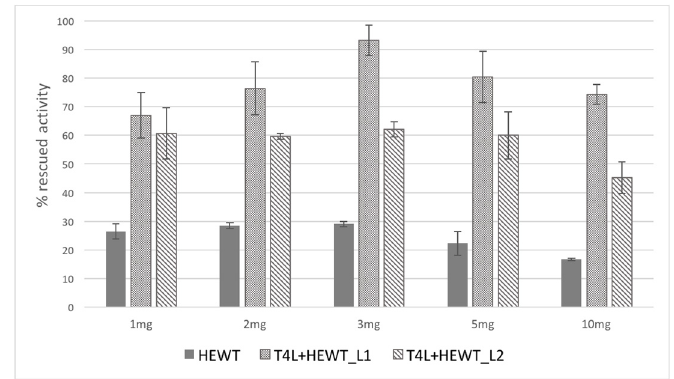
Figure 2. HEWT, T4L + HEWT_L1 and T4L + HEWT_L2 immobilisation (24 h, room temperature, in 50 mM phosphate buffer pH 8) at different enzyme loading per gram of resin Sepabeads EC-EP/S (pore ø 10–20 nm).